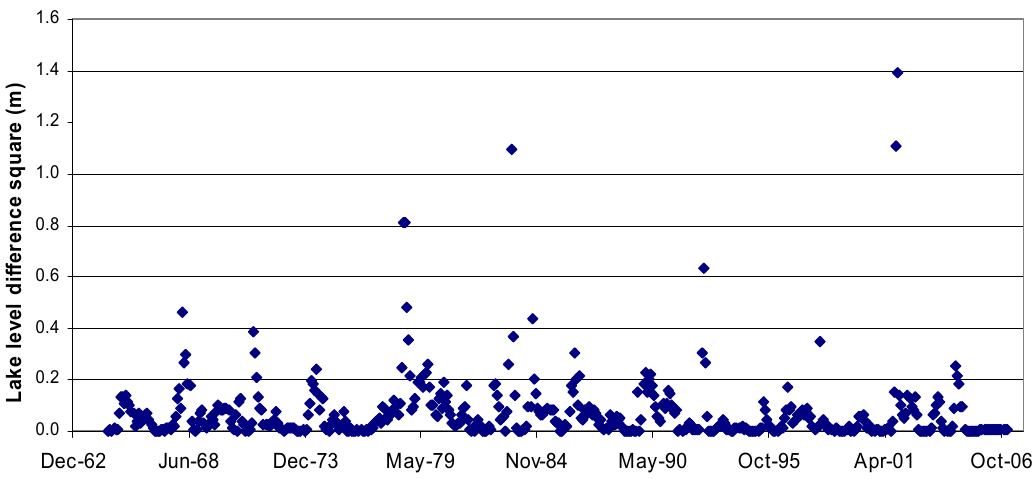
Hydrology 2017 , 4 , 10 Figure 12. Correlation between observed and calculated lake elevation in AHD m. Table 1. Average long ‐ term (1964–2007) monthly contribution (in percent) of each Lake Linlithgow water budget component to the overall lake water budget.